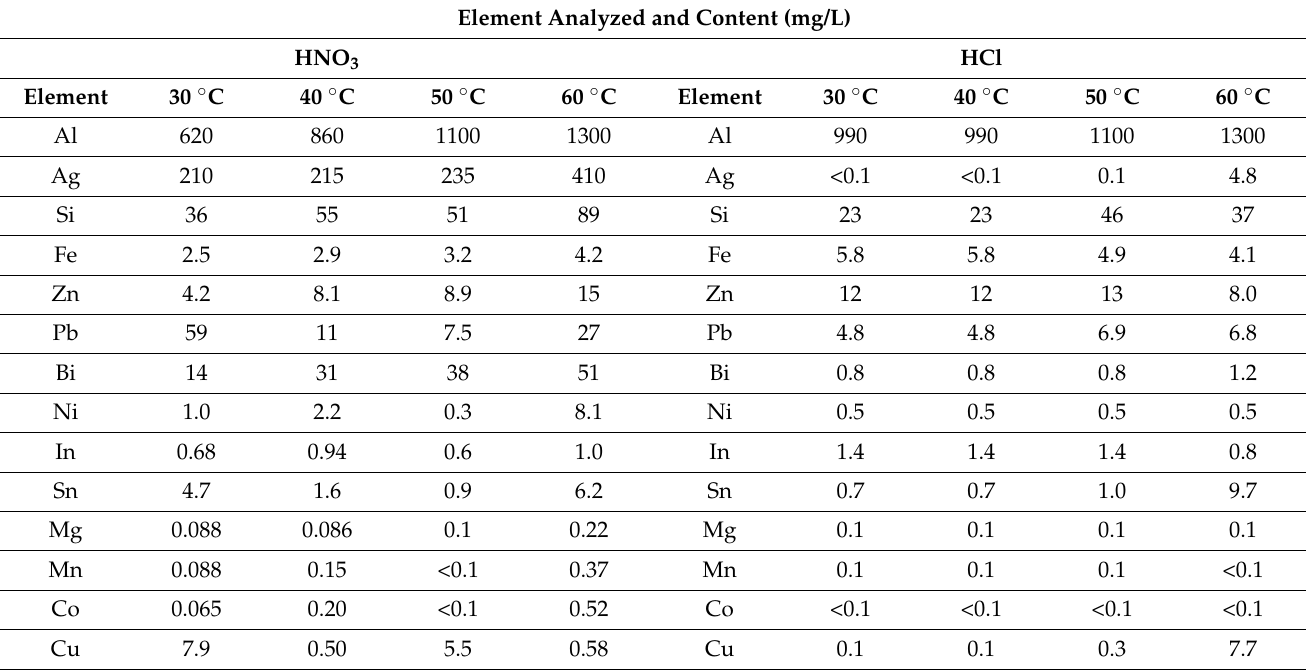
Table 5. ICP-Full Scan analysis results of the filtered solution—temperature.